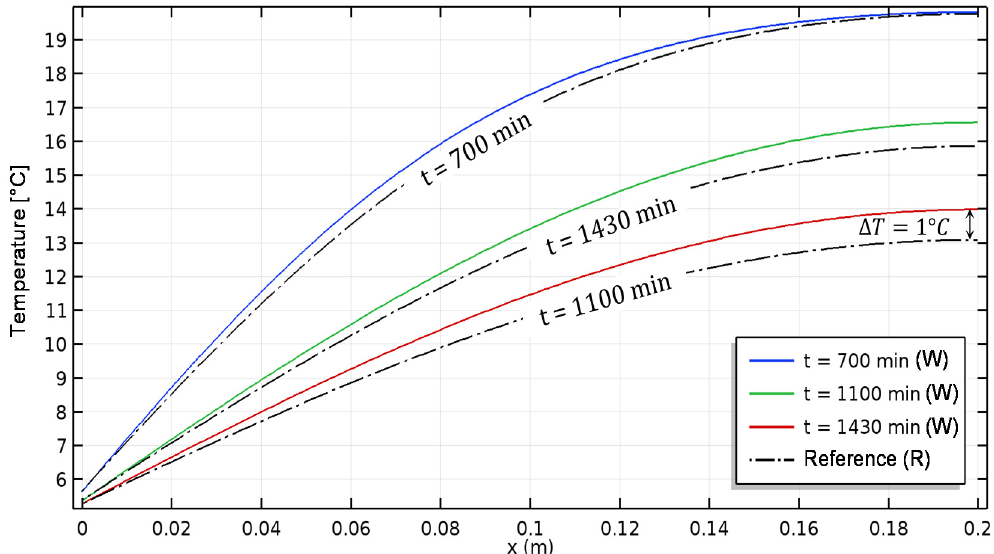
Figure 12. Non-isothermal case: Temperature profiles of aged and reference hemp concrete (W: Weathered; R: Reference).